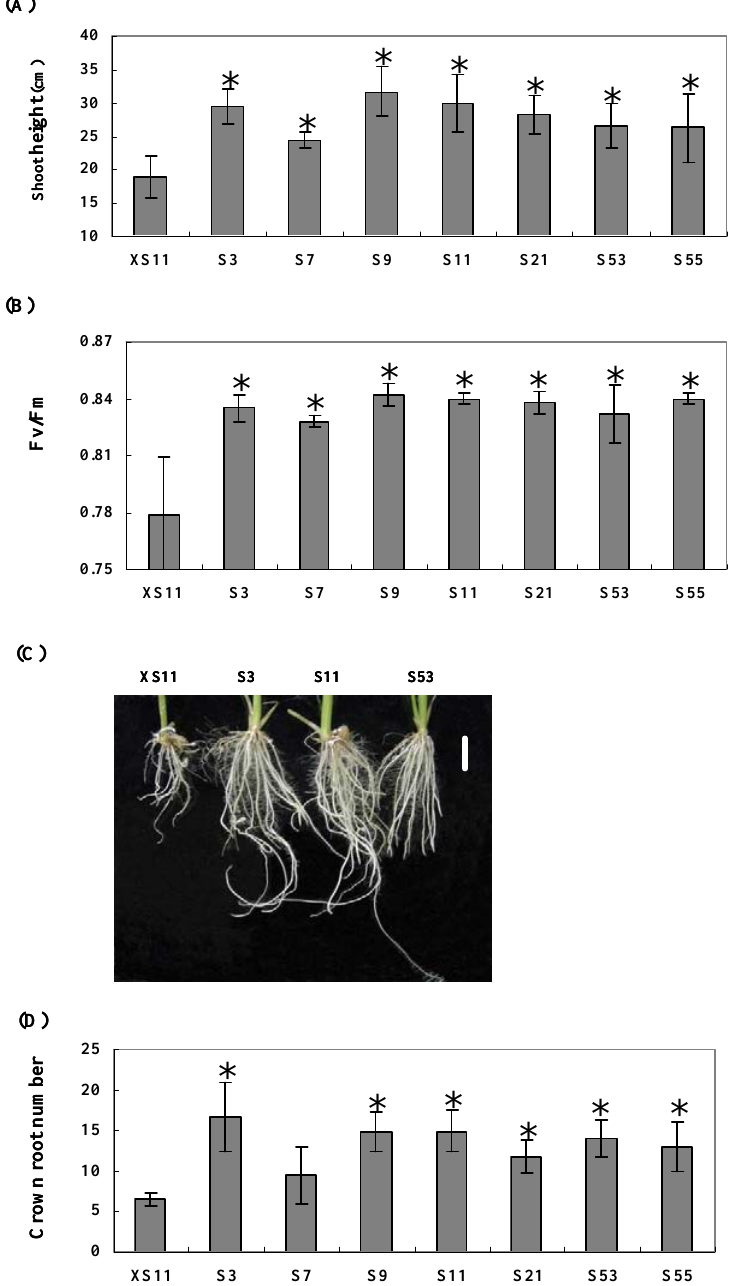
Figure 3. The recovery growth of rice plant after salt